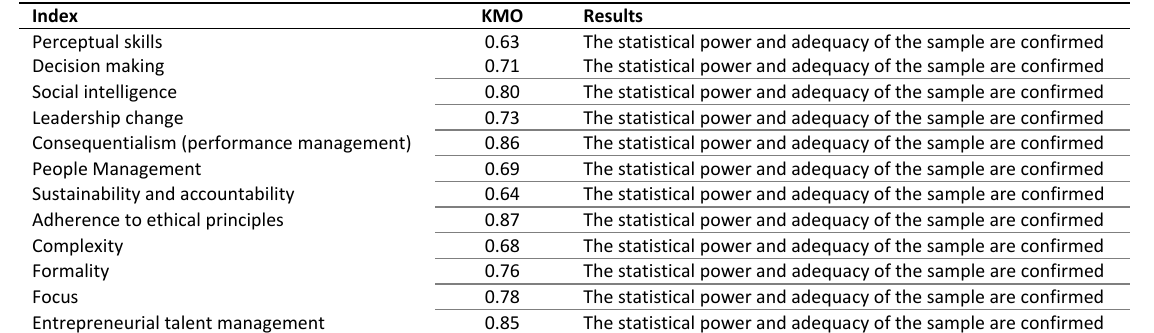
Table 5: KMO test results